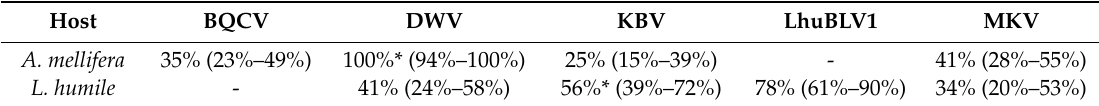
Figure 1. Venn diagram of virus coinfection in honey bees ( Apis mellifera ) ( A ) and Argentine ants ( Linepithema humile ) ( B ). Most prevalent viruses were DWV in honey bees and LhuBLV1 in Argentine ants. BQCV: black queen cell virus; DWV: deformed wing virus; KBV: Kashmir bee virus; LhuBLV1: Linepithema humile bunya-like virus 1; MKV: Moku virus. Table 2. Estimated viral prevalence in honey bees ( Apis mellifera ) and Argentine ants ( Linepithema humile ) for five virus targets with 95% confidence intervals (CI) in brackets. - indicates that the virus was not detected in the species and * indicates a significantly higher prevalence in a test of proportions. BQCV: black queen cell virus; DWV: deformed wing virus; KBV: Kashmir bee virus; LhuBLV1: Linepithema humile bunya-like virus 1; MKV: Moku virus.